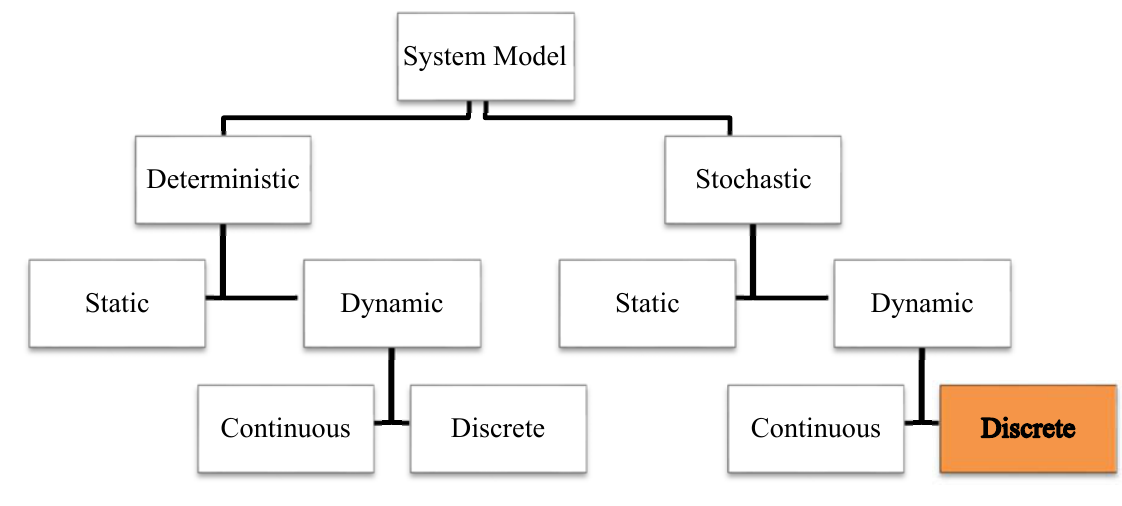
Fig. 2 . The position of discrete event simulation in system